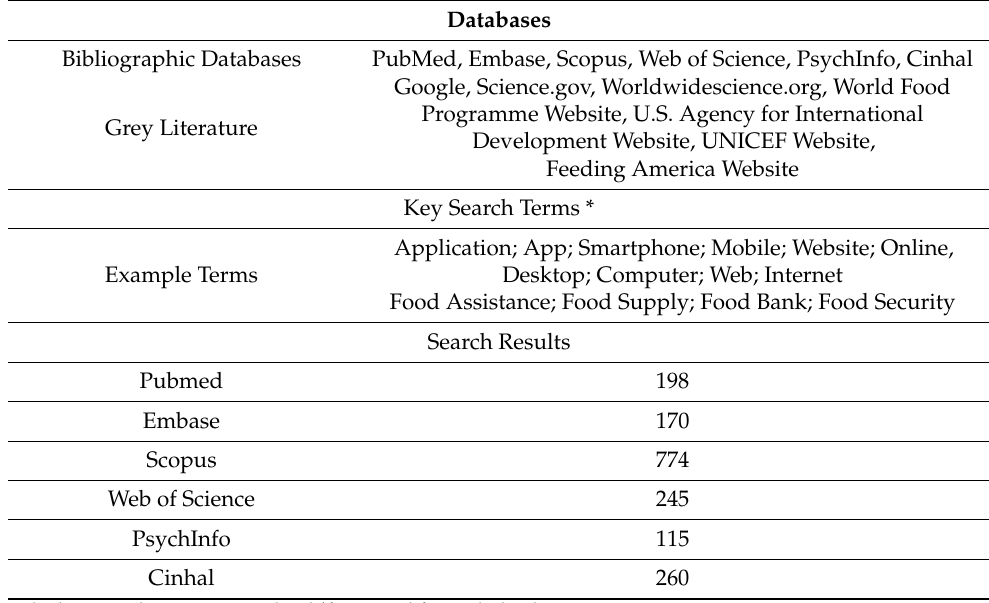
Table 1. Databases included, search Terms utilized, and search results by database.